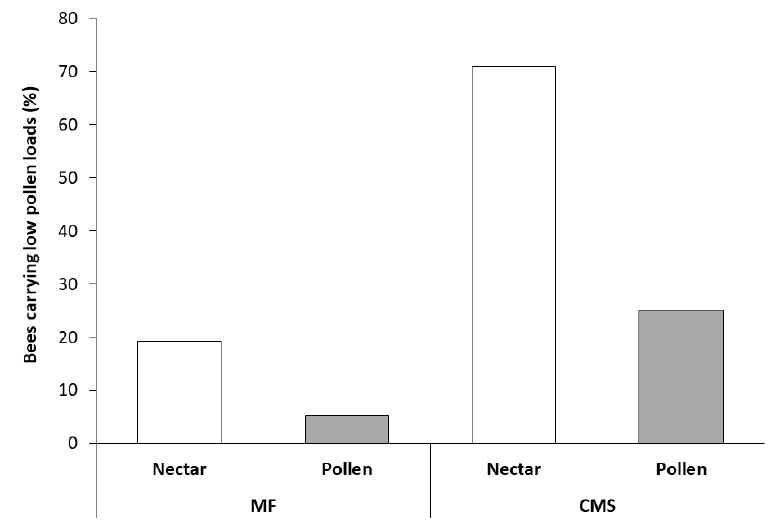
Figure 2 . Percentage of Apis mellifera carrying low pollen loads (<10 pollen grains) visiting male ‐ fertile (MF) and cytoplasmically male ‐ sterile (CMS) carrot umbels. Both bee type (nectar ‐ or pollen ‐ foragers) and flower type (MF or CMS) significantly influenced bee body pollen count. The sample size was 122 bees in total. Samples per column are MF nectar = 69, MF pollen = 6, CMS nectar = 26, CMS pollen = 19.